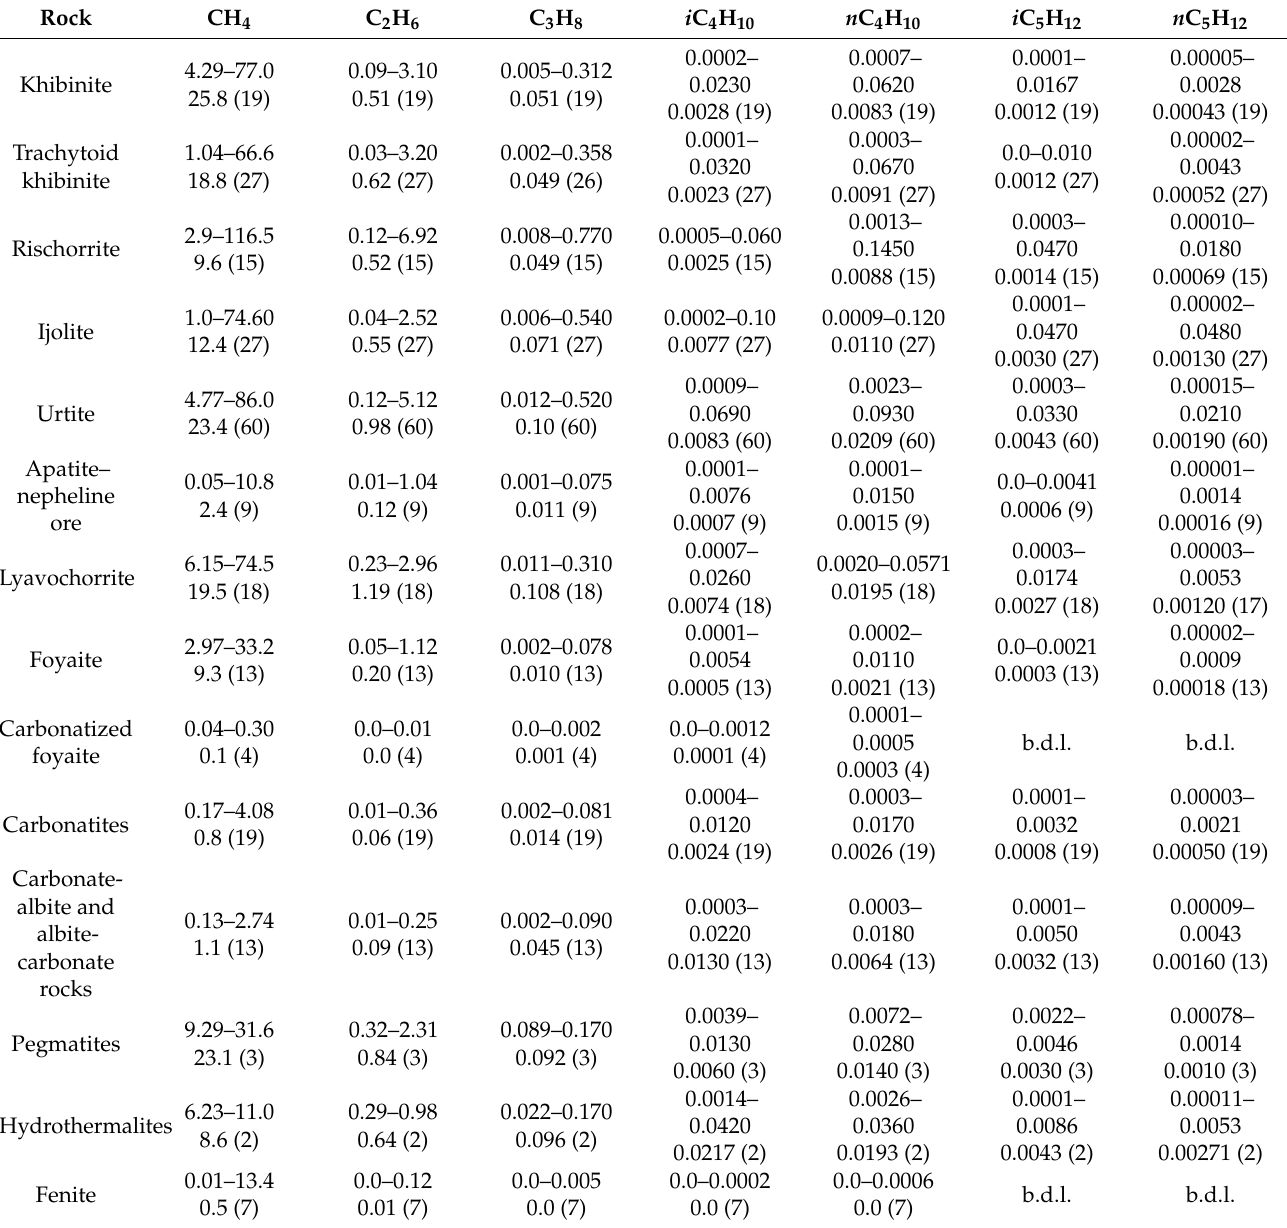
Table 1. Concentrations of occluded hydrocarbon gases in the Khibiny massif {min-max/median (number of analyses)}, cm 3